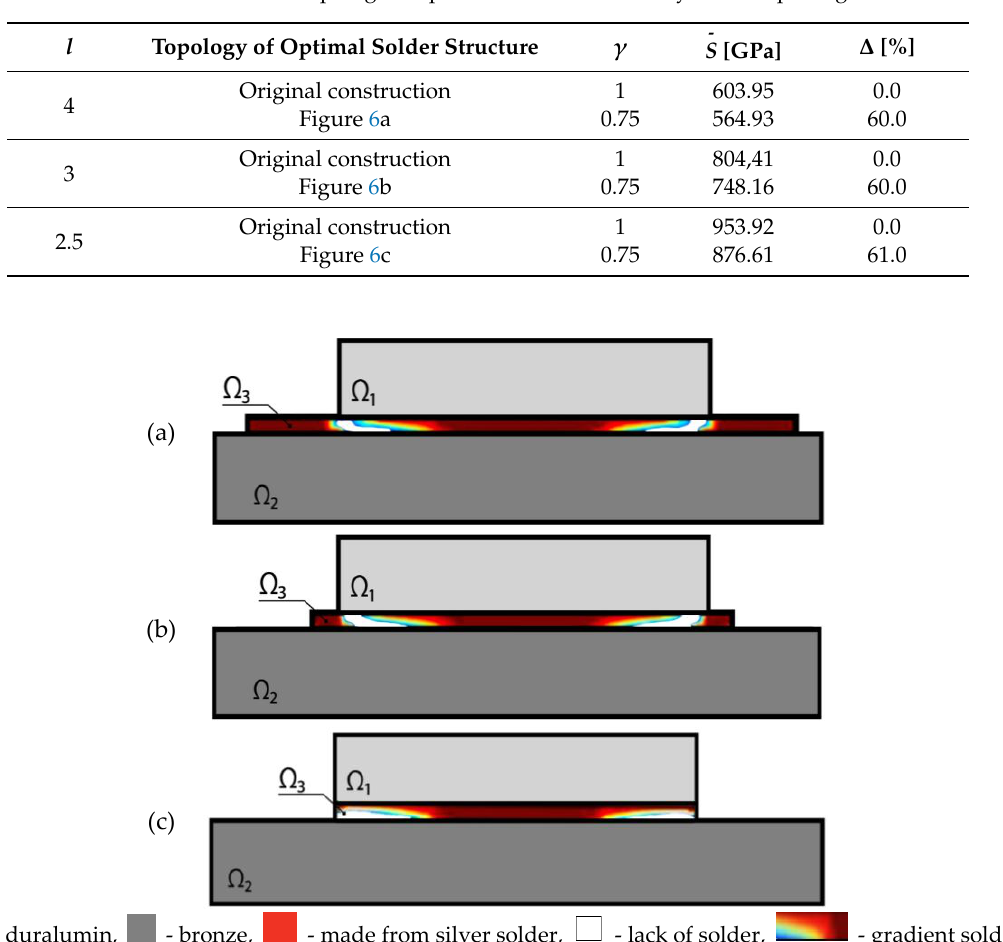
Figure 6. Topology of the optimal structure for the solder of the non-symmetric package. ( a ) l = 4, γ = 0.75; ( b ) l = 3, γ = 0.75; ( c ) l = 2.5, γ =